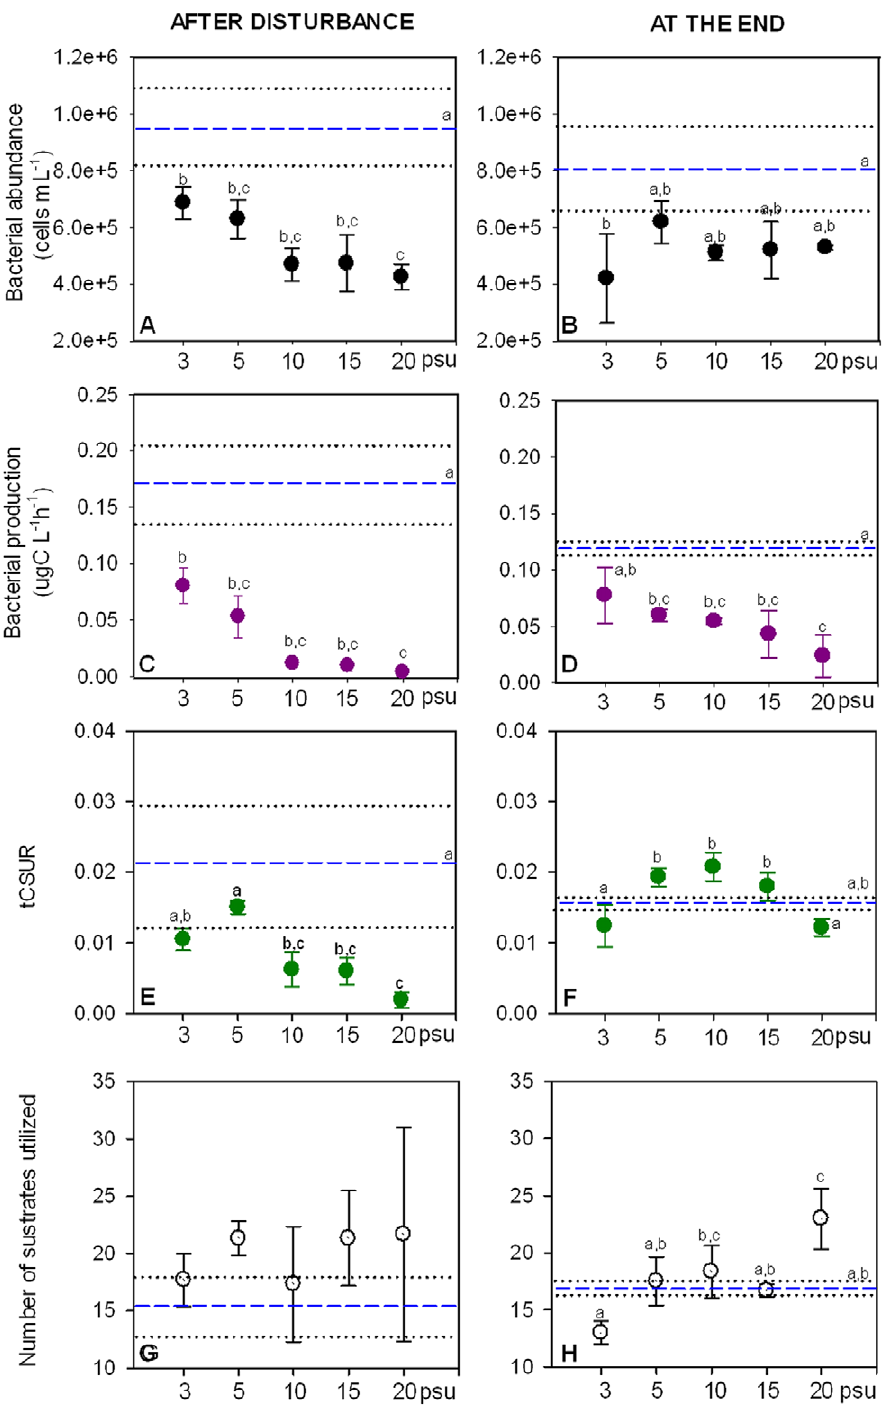
Figure 3. Functional changes in the disturbance intensity experiment (Experiment 1). Values presented correspond to mean values 6 standard deviation of bacterial abundance (A, B), bacterial production (C, D), total carbon substrate utilization rate (tCSUR; E, F) and number of substrates with a positive response (G, H) for the different treatments. Mean values of controls are represented as dashed lines (- -), while standard deviation from control are represented as dotted lines ( ??? ). Tukey’s homogenous groups are represented by a, b and c. doi:10.1371/journal.pone.0036959.g003 declined on average 48 6 26% from the control after the Carbon substrates utilization rates and number of positive substrates. Increases in disturbance intensity (Exper- disturbance but was reduced to 66 6 13% at the end of the iment 1) significantly decreased tCSURs after the disturbance (F: experiment (Fig. 4C and 4D) 14.920, p , 0.001), with the exception of the lowest salinity